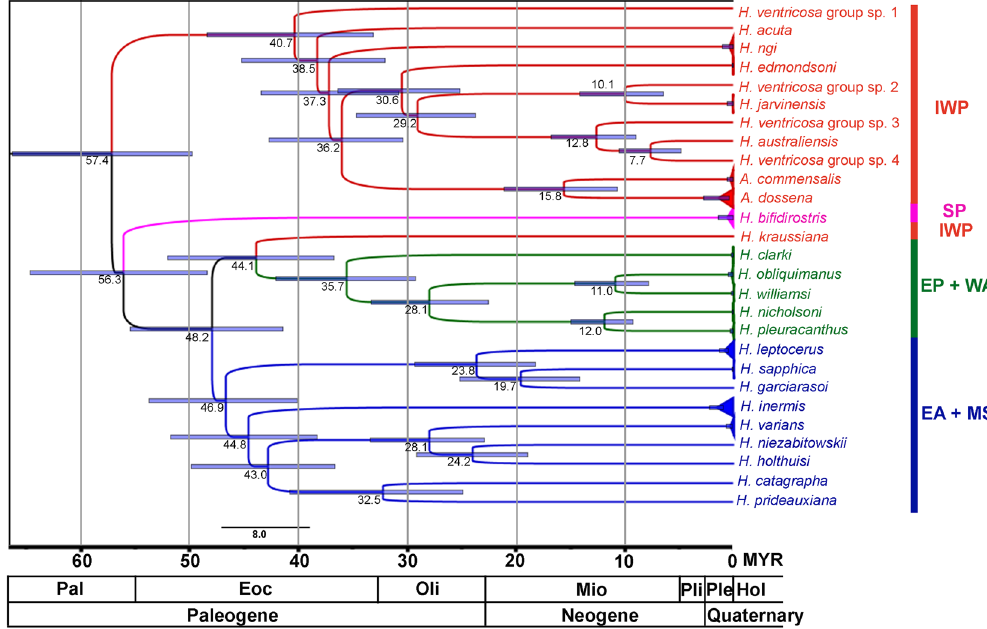
Figure 4. Divergence time chronogram for Hippolyte species estimated using a Bayesian analysis for concatenated dataset 16S/COI. Mean divergence time estimates (million years ago = MYR) are noted adjacent to their respective nodes, the bars represent the highest posterior density (95%). Geological periods of Cenozoic Era are superimposed onto the phylogeny, abbreviated as follows: Hol, Holocene; Ple, Pleistocene; Pli, Pliocene; Mio, Miocene; Oli, Oligocene; Eoc, Eocene; Pal, Paleocene. Outgroups have been excluded from the phylogeny. Biogeographical regions as in Fig.